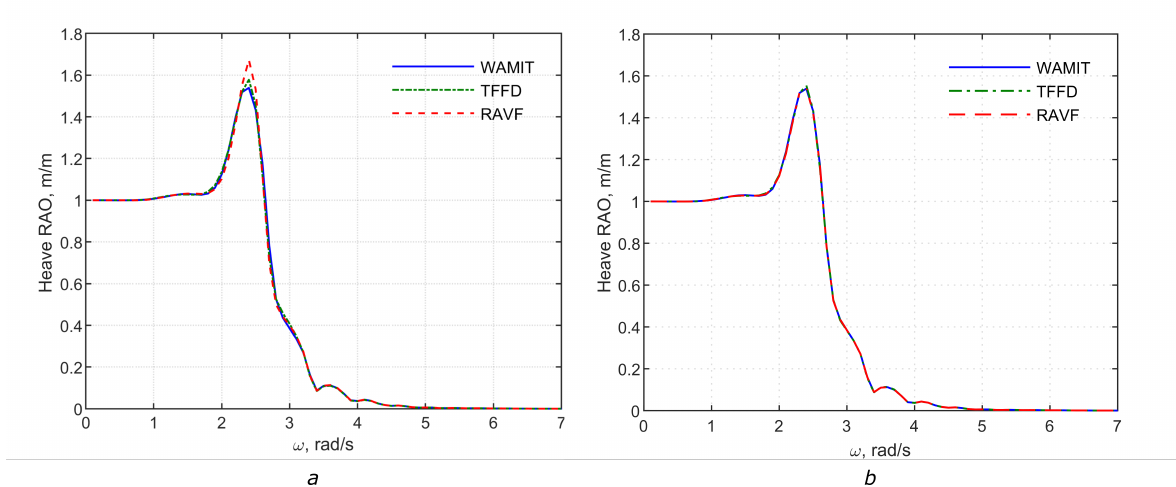
Figure 9. Comparison of RAO, made for the buoy with a radius of 2 m, calculated with: ( a ) the fitting order of 4; ( b ) the fitting order of 8. The passivity condition was